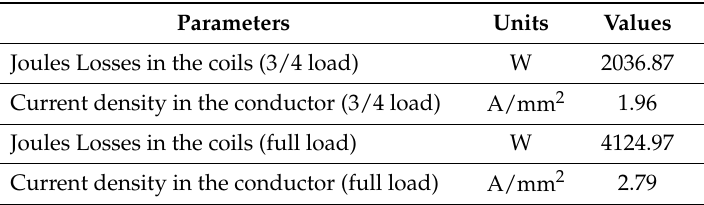
Table 10. Losses in the stator (Joule losses).